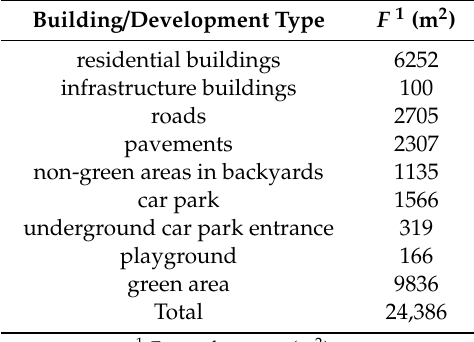
Table 2. The land use of the housing estate area.